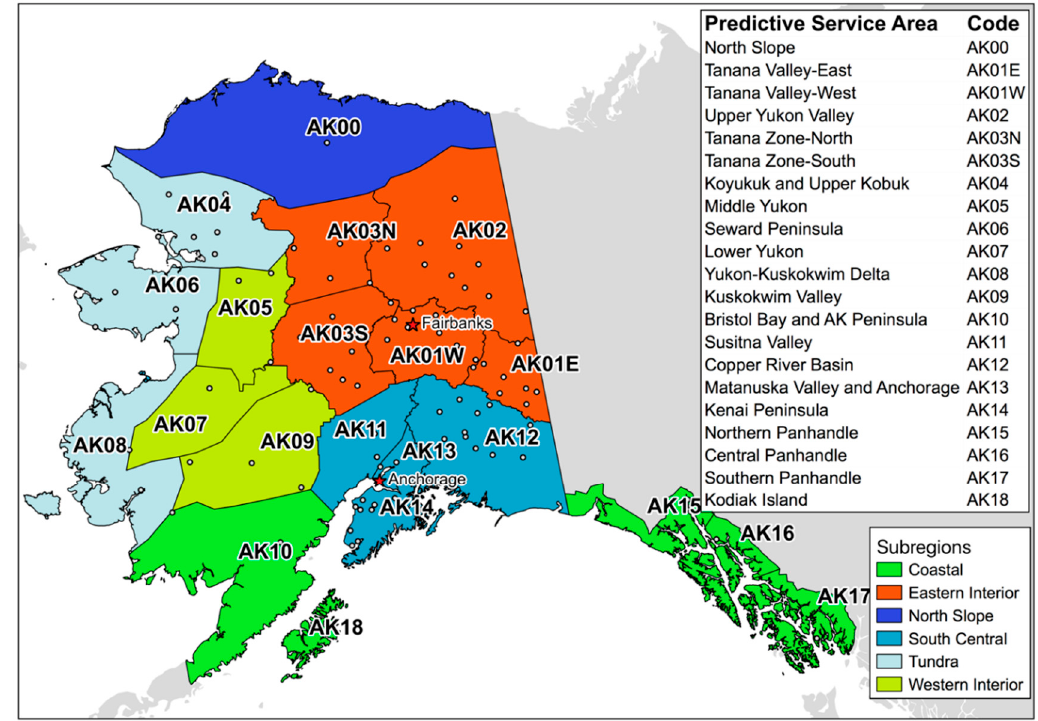
Figure 1. Map of Alaska with outlines of fire management Predictive Service Areas with names and codes. Surface observation locations used in this study are depicted with circles, and the five subregions are shaded.